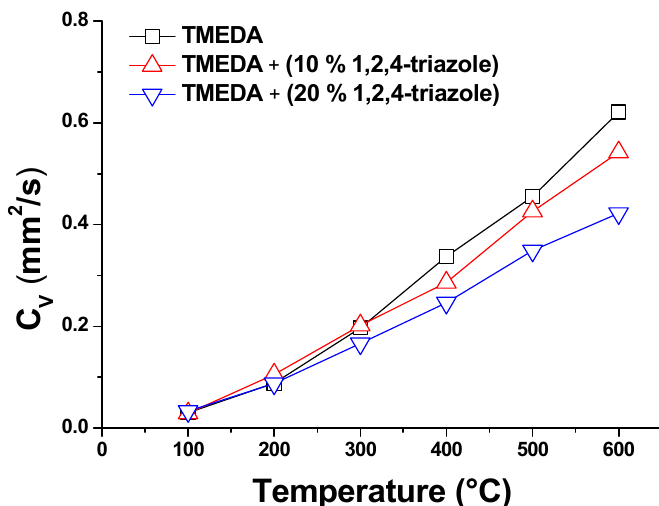
Figure 15. Evaporation coefficients of the TMEDA-based fuels at temperatures of 100–600 °C for the first stage evaporation period.